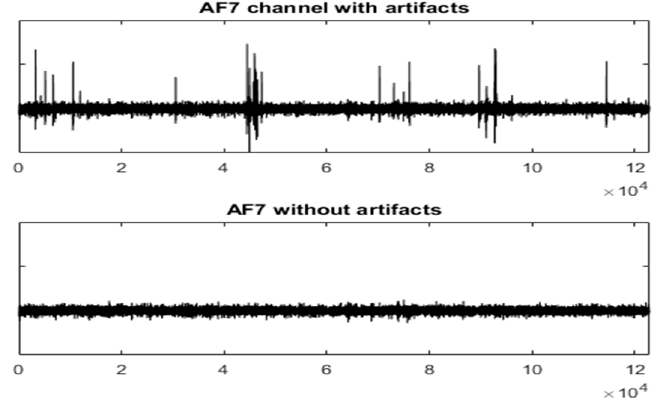
Figure 9. The AF7 channel of AEEG with and without artefacts. The X axes shows the samples.